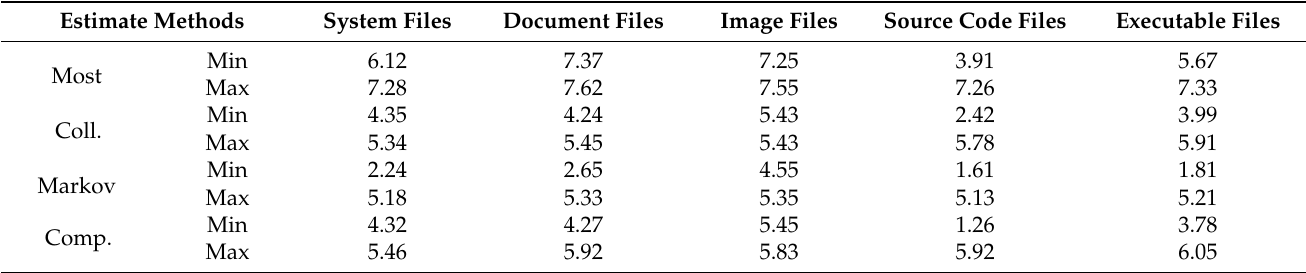
Table 3. Optimal entropy baseline values.